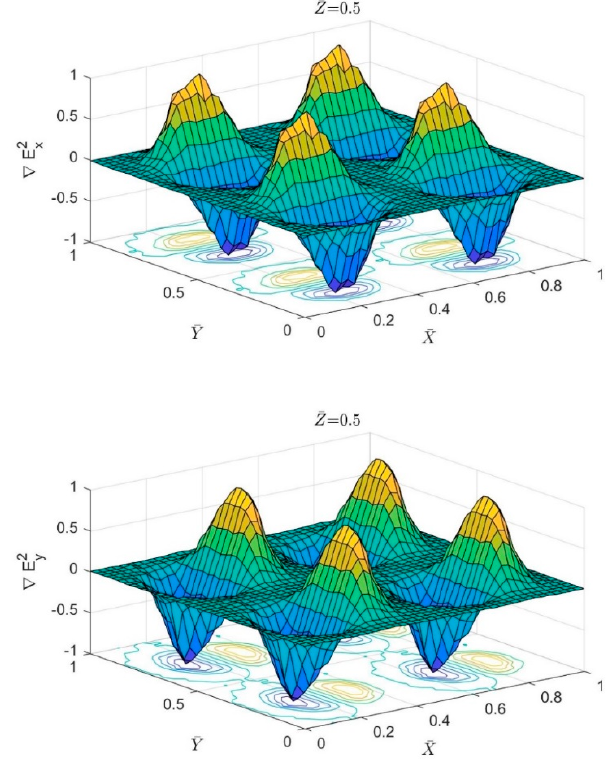
Figure 3. The normalized variation of the term 𝛁𝐸 (cid:3019)(cid:3014)(cid:3020)(cid:2870) in the XY plane at 𝑍 (cid:3365) = 0.5. The first subfigure shows the variation in the X-component while the second one is for the variation in